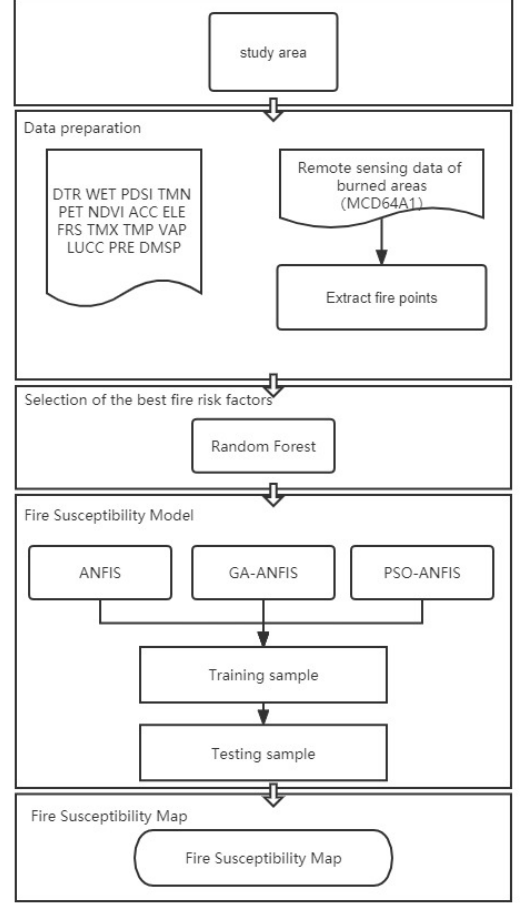
Figure 2. Flowchart of the developed methodology.